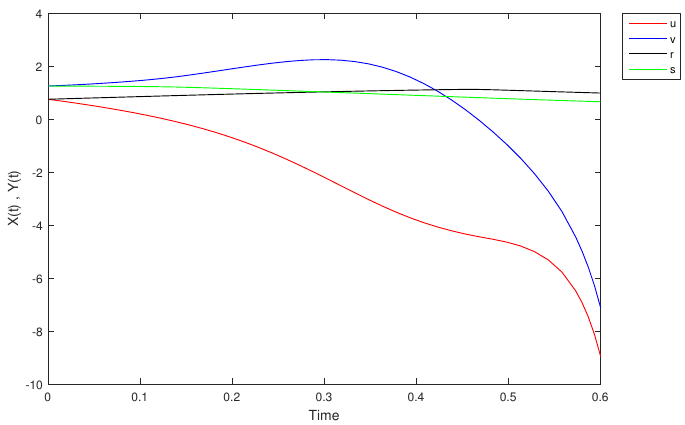
Figure 21. The solution of (11) at α = 0.5.